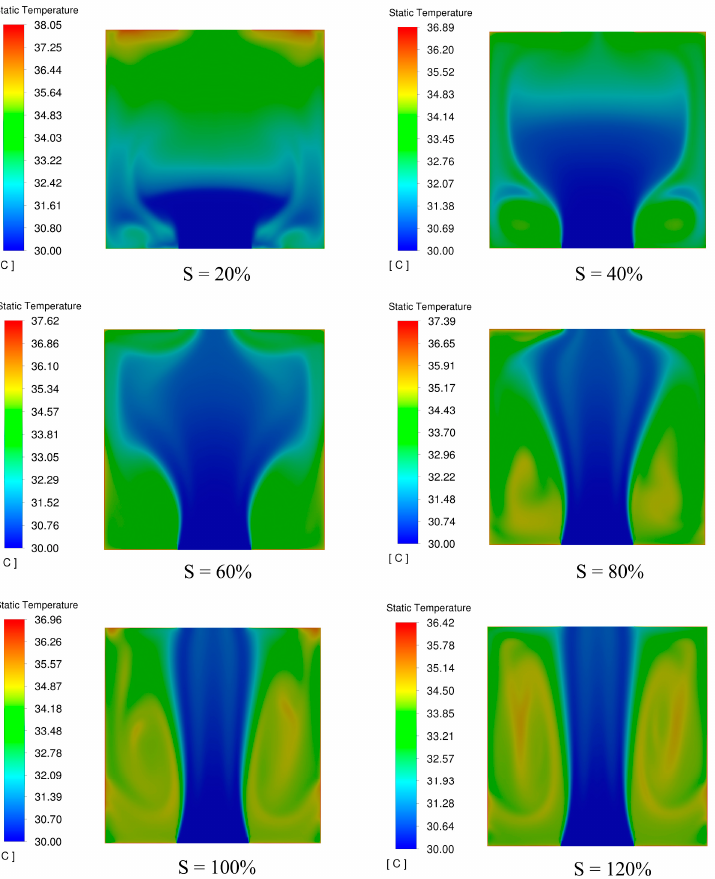
Figure 6. Distribution maps of the internal temperature field of the wall-mounted solar chimney under different